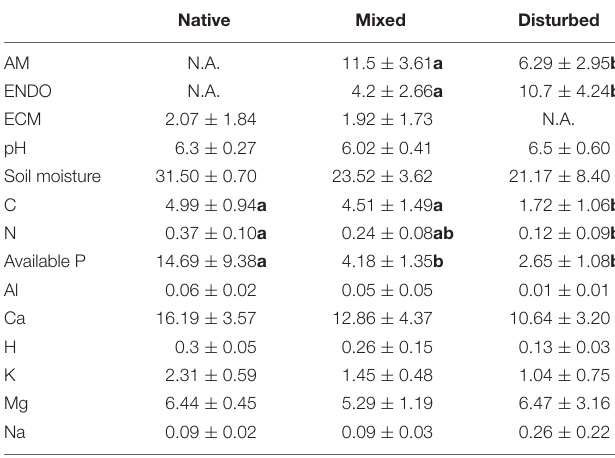
TABLE 1 | Mean and standard deviation of root colonization measurements and soil variables across sites (native, mixed and disturbed) with significant Tukey’s HSD tests ( P ≤ 0.05) indicated with bold